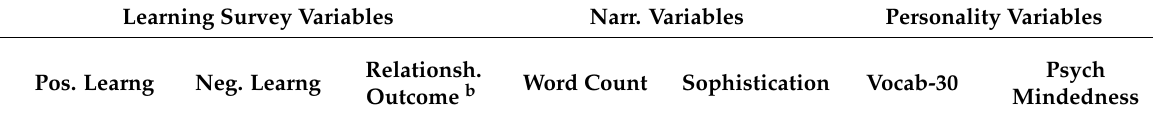
Table 3. Correlations and Confidence Intervals a Among the Key Variables of Study 1, N =